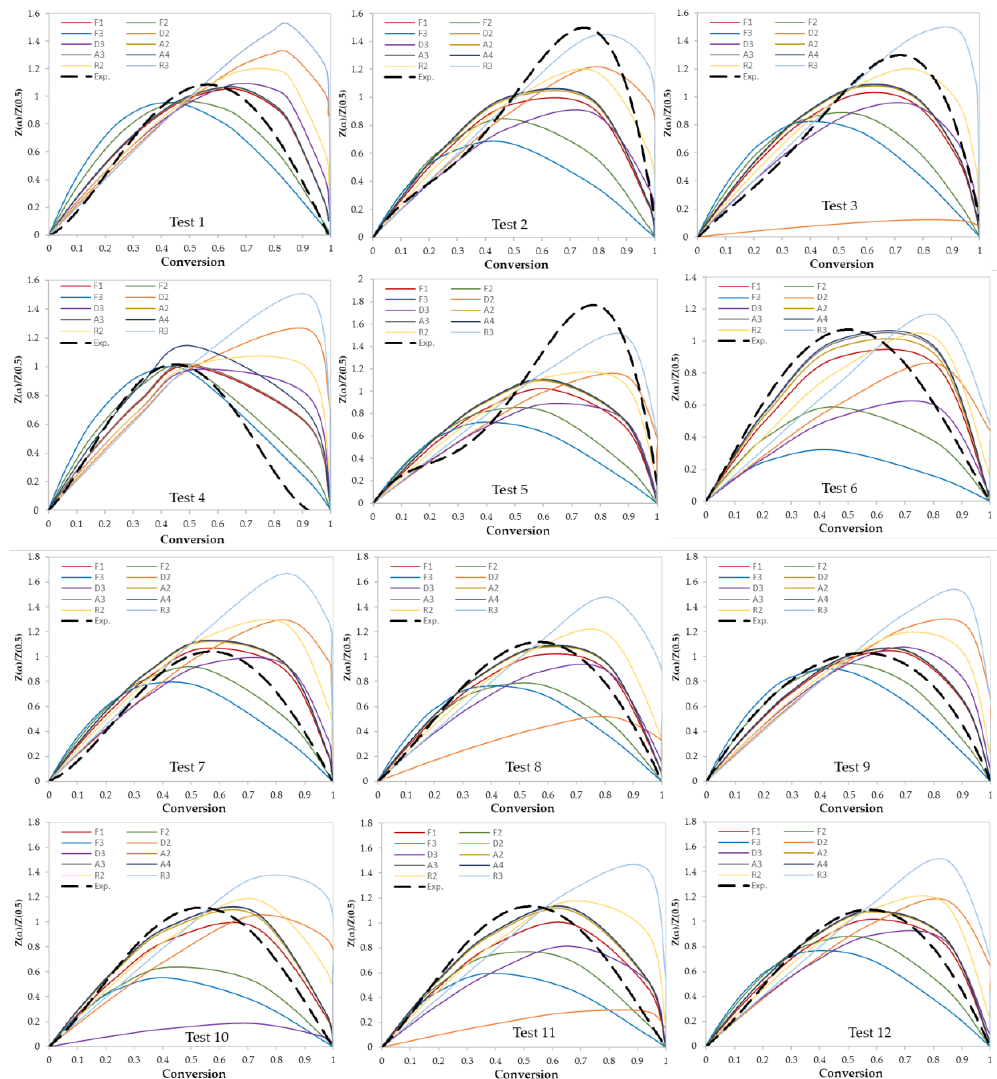
Figure 6. Criado model master plots of binary polymer mixtures. Materials 2020 , 13 , x FOR PEER REVIEW 11 of 14